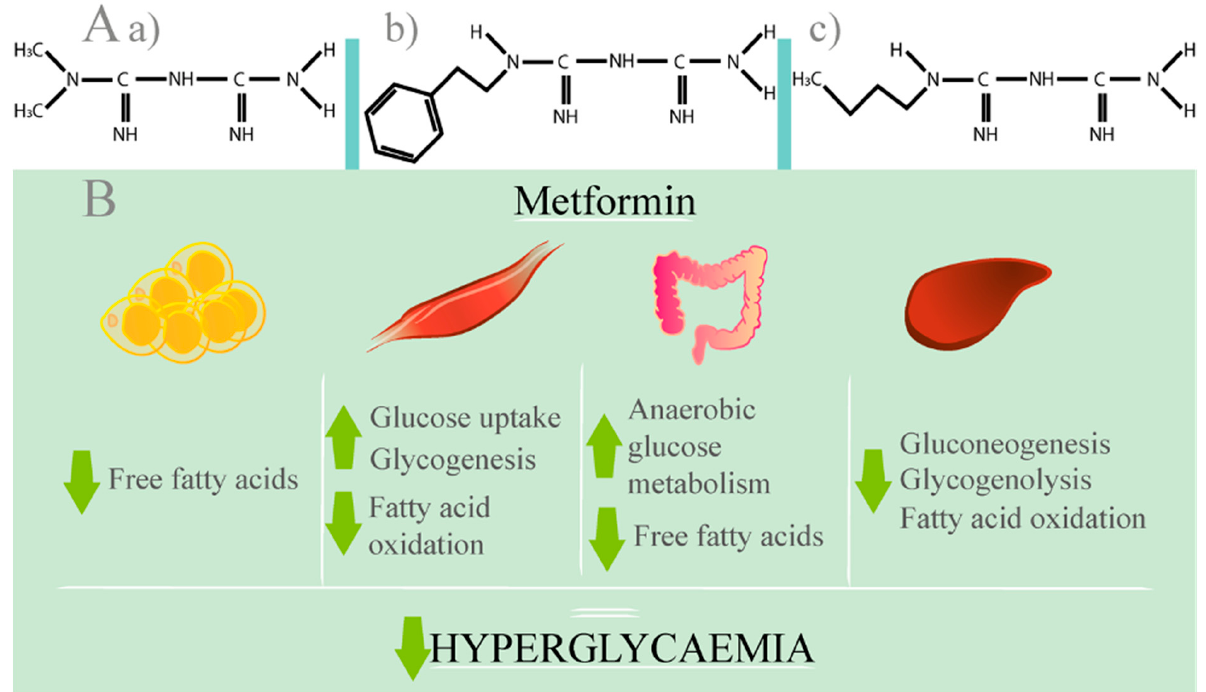
Figure 2. Biguanides’ structure and the historically accepted actions of metformin. Panel ( A ) illus- trates the chemical structure of biguanides, including metformin; ( a ) Chemical structure of metformin; ( b ) Chemical structure of phenformin; ( c ) Chemical structure of buformin. Panel ( B ) demonstrates many historically accepted mechanisms by which metformin reduces hyperglycaemia.